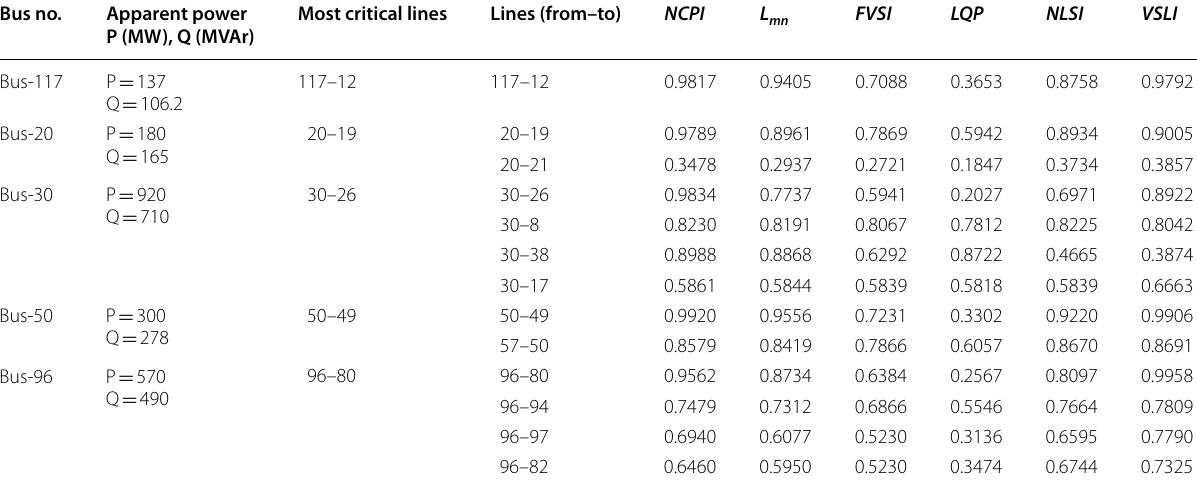
Table 8 The line stability indices for the IEEE 118-bus system under heavy apparent power load Bus